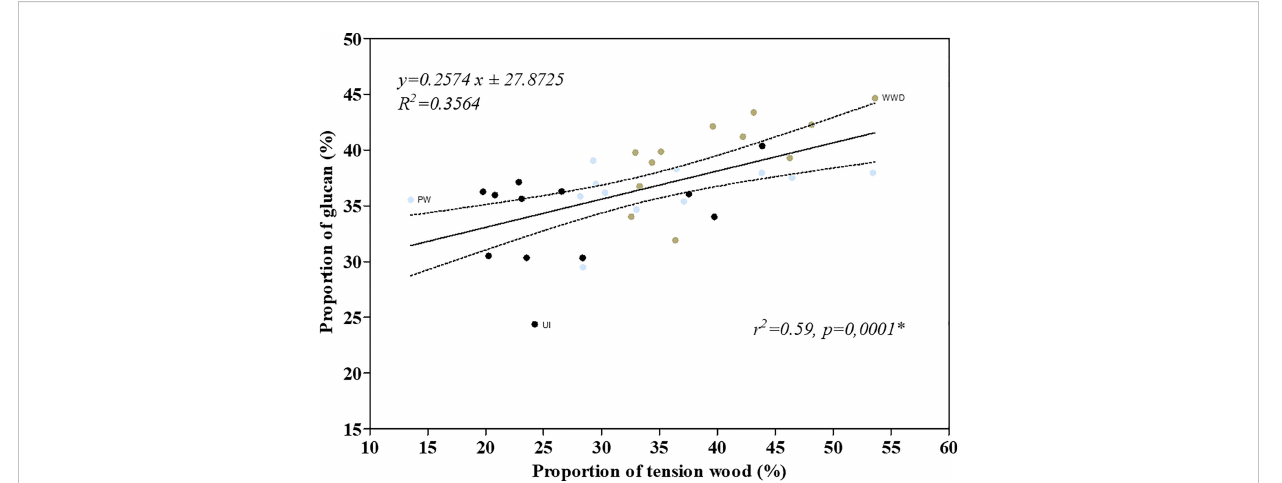
FIGURE 3 Linear regression between the tension wood proportion and the biomass glucan proportion of the cultivar Salix miyabeana SX67. Black, blue and brown dots refers respectively to the data of UI, PW and WWD